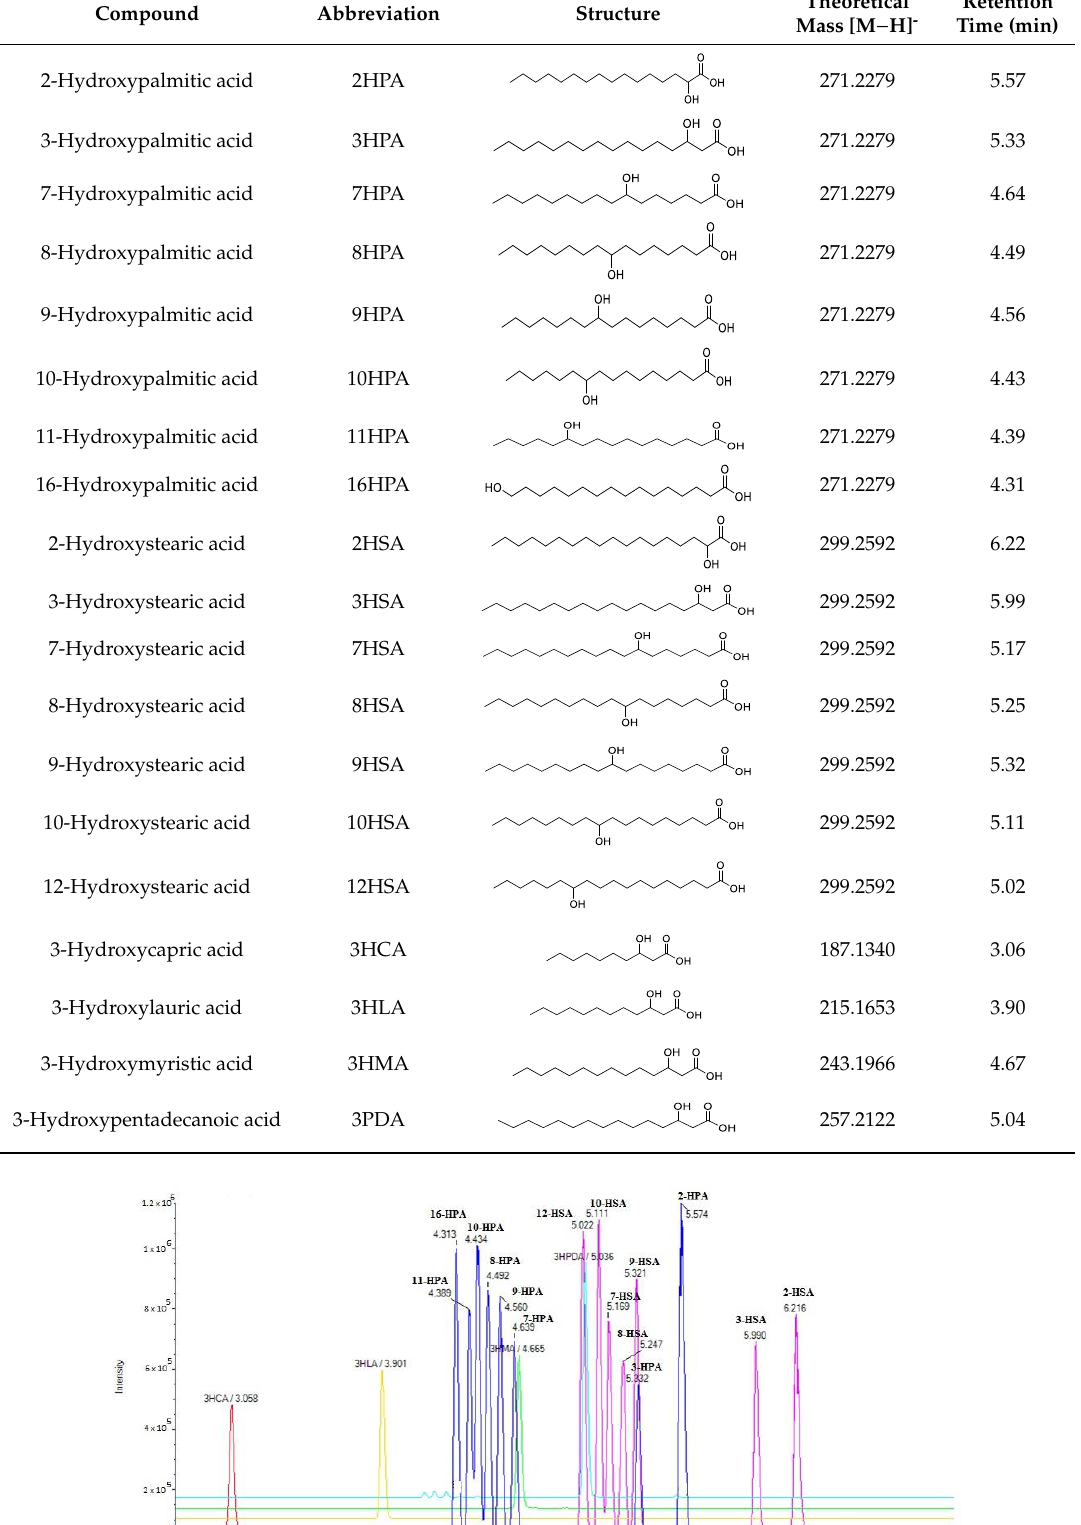
Table 1. Hydroxy fatty acid standards used in the chromatographic method.